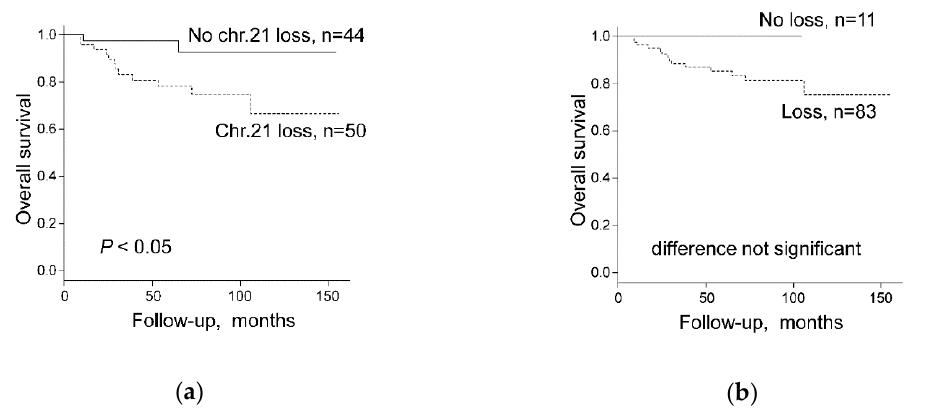
Figure 5. Overall survival stratified by ( a ) chromosome 21 status (Chr.21 loss versus No chr.21 loss)